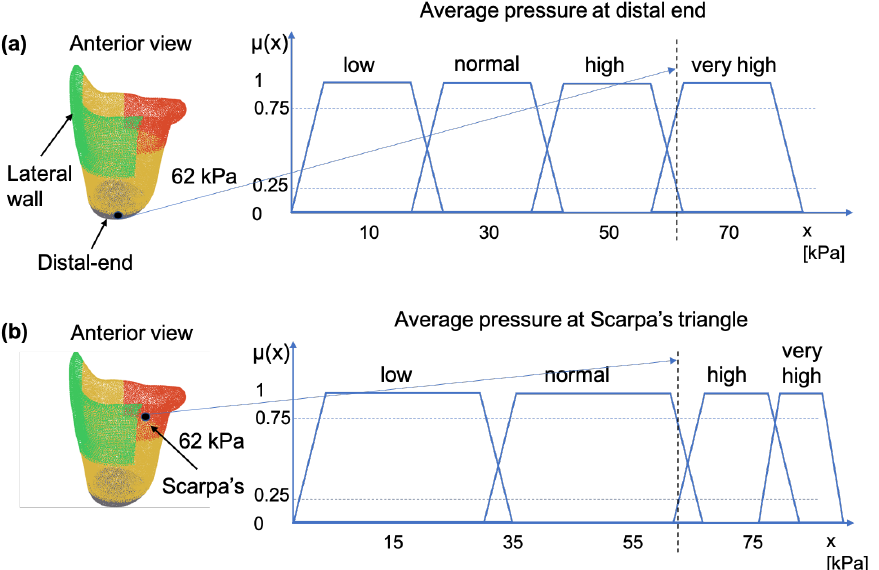
Figure 3. Membership functions for pressure measurements taken at: ( a ) the distal-end, and ( b ) at the Scarpa’s triangle. The two areas are indicated on the socket figure by the black